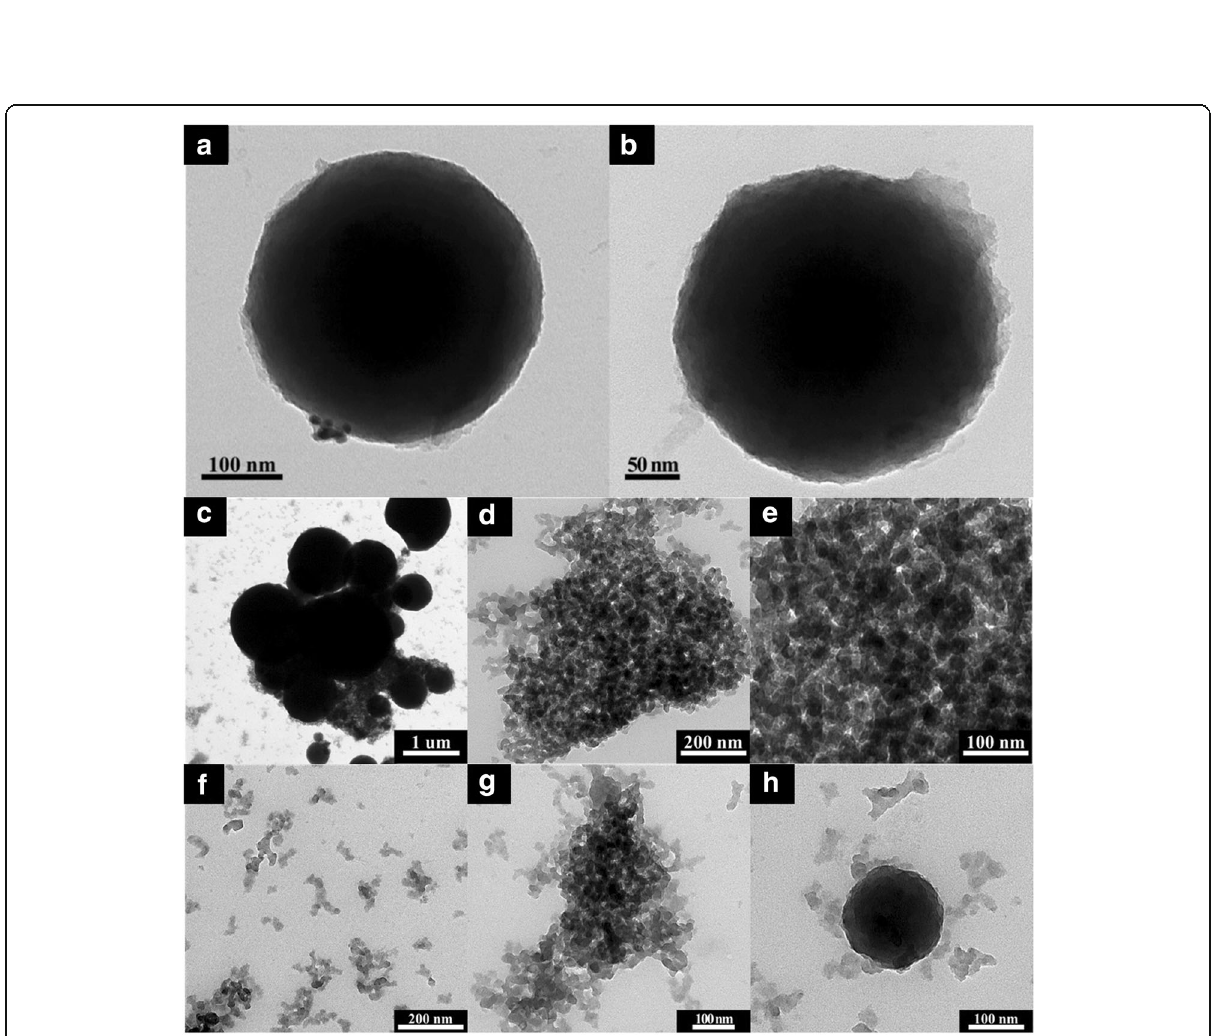
Fig. 7 TEM morphology of cellulose-amino POSS hybrid composite (a-c) sol-gel process (d-h) PVA/THPC